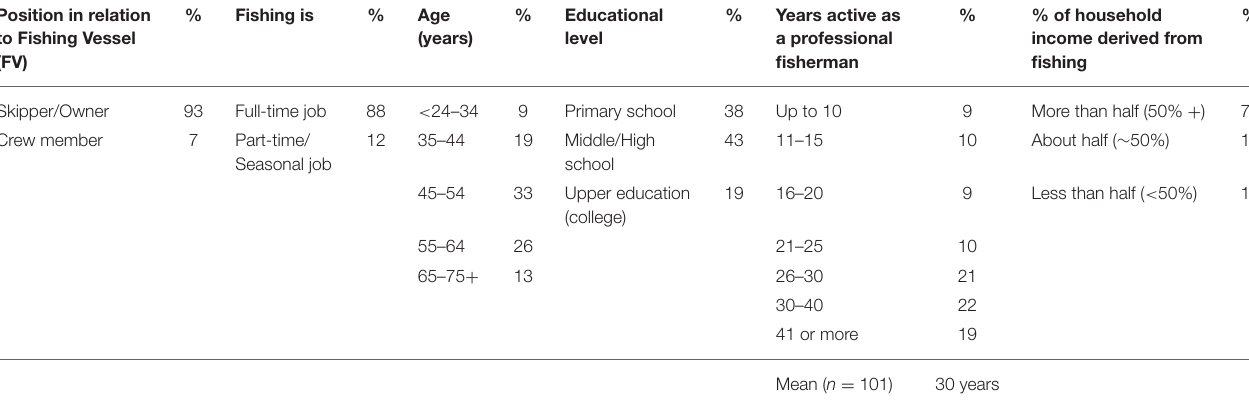
TABLE 1 | Demographic characteristics of fishermen who participated in the study of fisherman interactions with sea turtles ( n = 101). Position in relation to Fishing Vessel